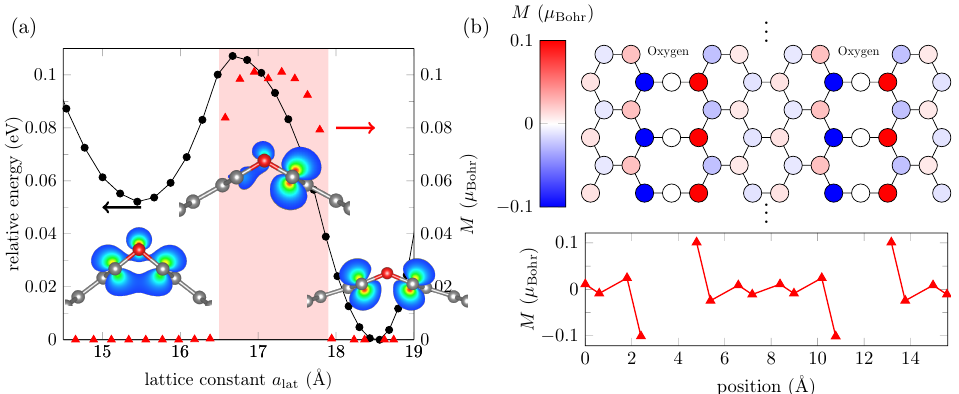
Figure 2. ( a ) Energy (black marks) and maximum magnetization (red marks) found in optimized GO nanoribbons of different widths, according to DFT calculations. The red shadowed area indicates non-zero magnetization for structures in the corresponding lattice constant range. The insets show partial charge densities around the oxygen atoms (red balls) and carbon atoms (gray balls) for three a lat values: 15.5Å, 17Å, and 18.5Å. ( b ) Magnetization at each atomic site in the unit cell of a GO layer of a lat =